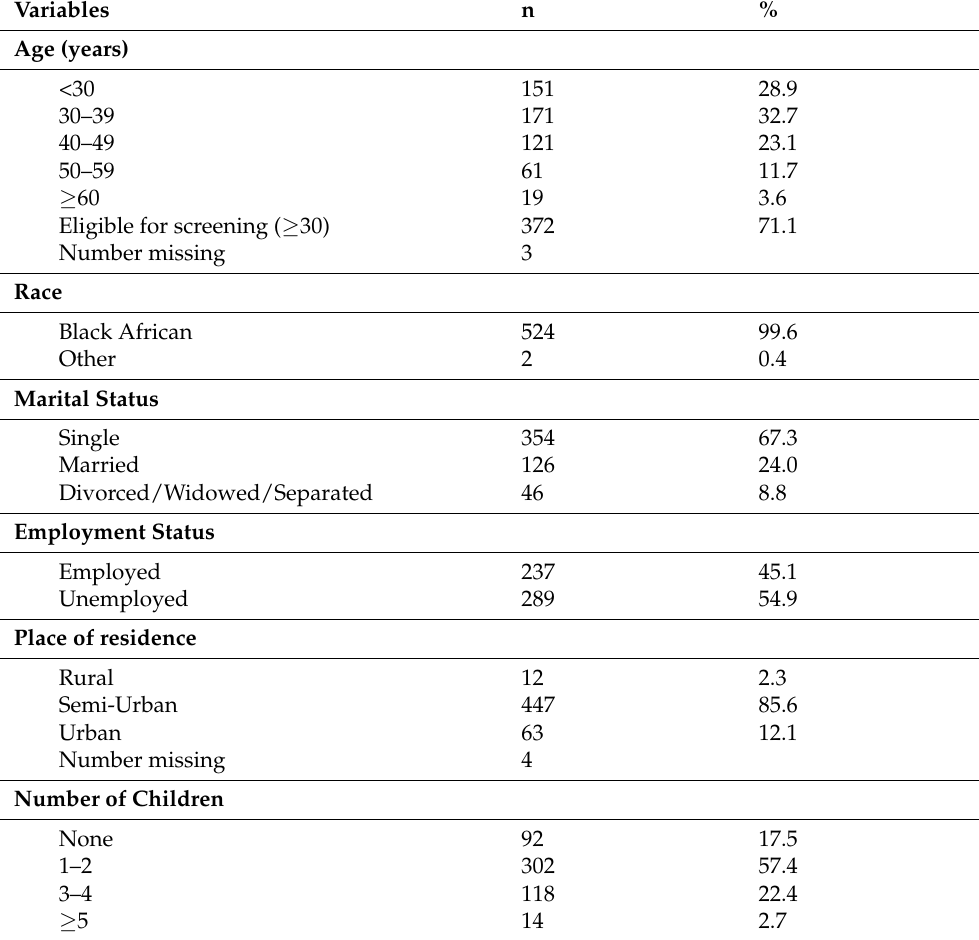
Table 1. Socio-demographic characteristics of the study